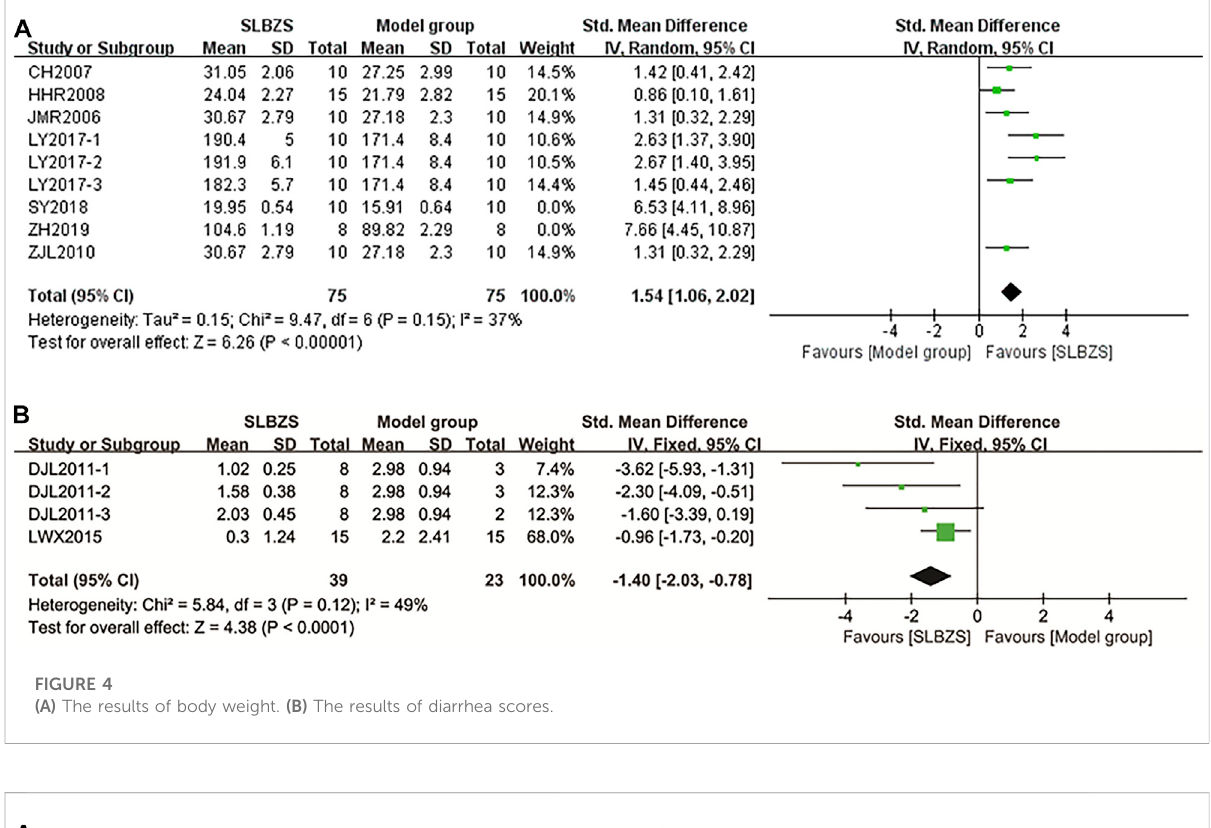
FIGURE 4 (A) The results of body weight. (B) The results of diarrhea scores.